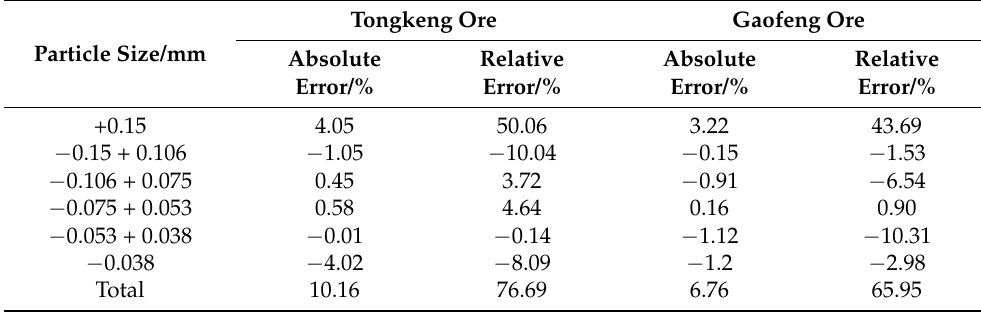
Table 8. Error comparison of Tongkeng ore and Gaofeng